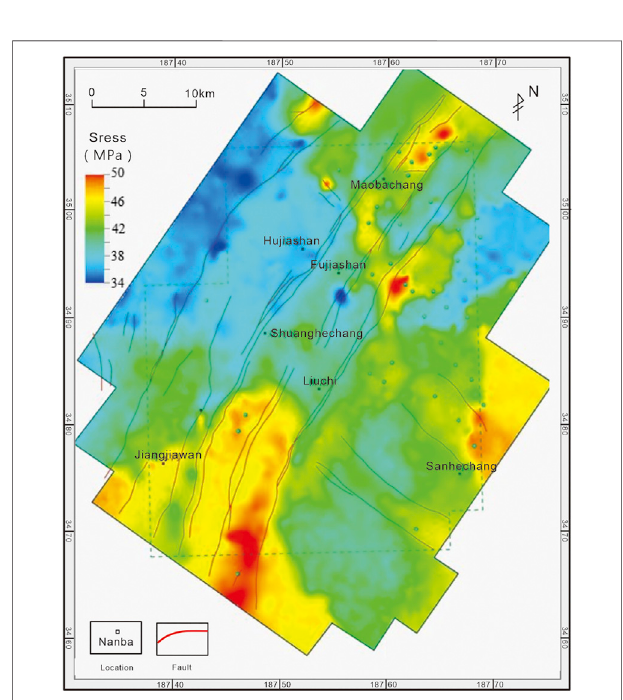
FIGURE 7 | The contour map of E-W fracture opening pressure in the second member of Jialingjiang formation, Puguang area.